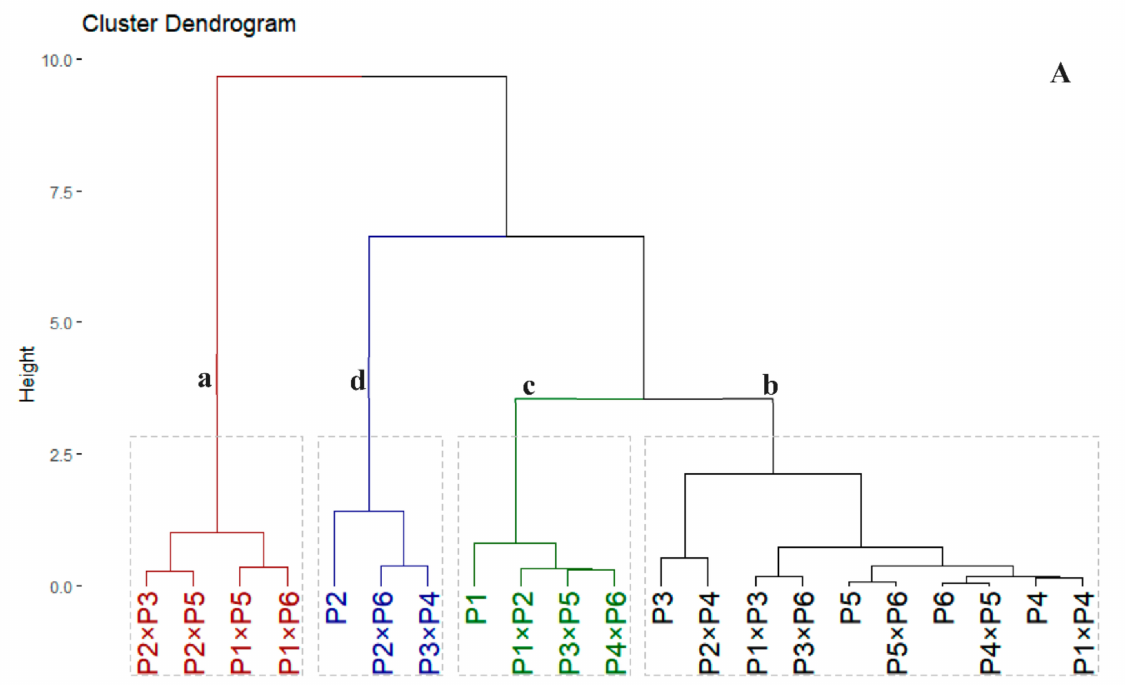
Figure 5. Effect of late sowing on each trait scored on the 21 wheat genotypes. Blue columns refer to the reduction on the trait and red column refers to the earliness in